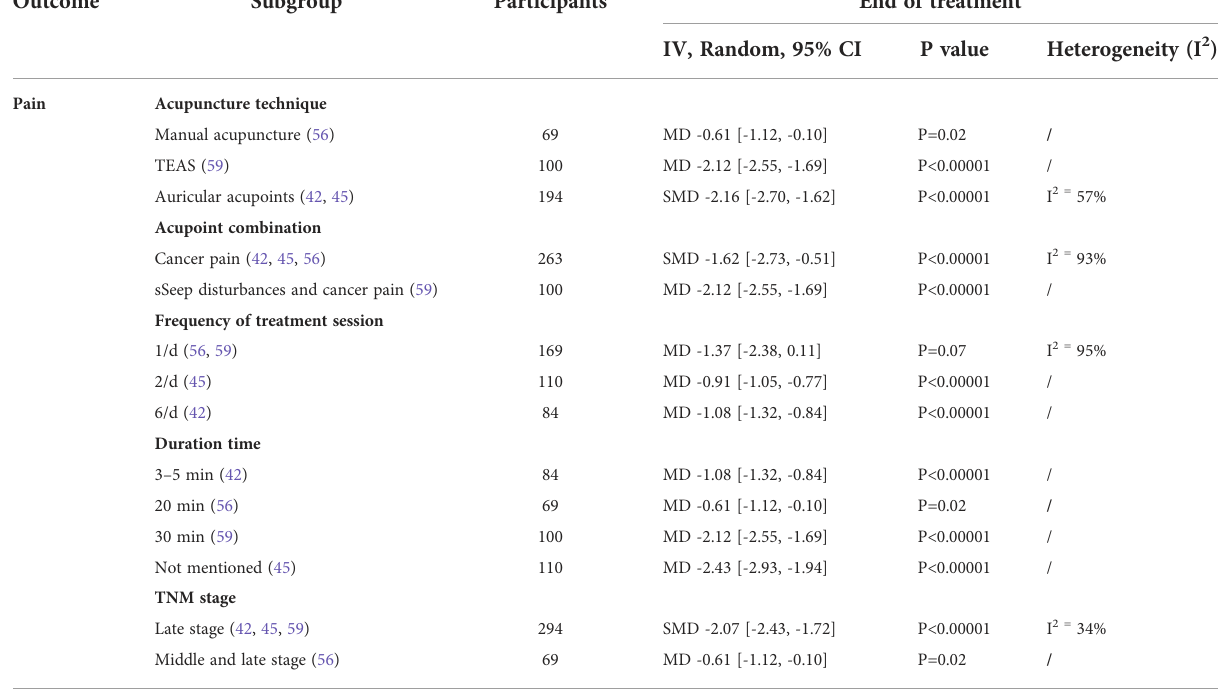
TABLE 3 Subgroup analysis of the combination of NRS and VAS in patients with cancer pain. Outcome Subgroup